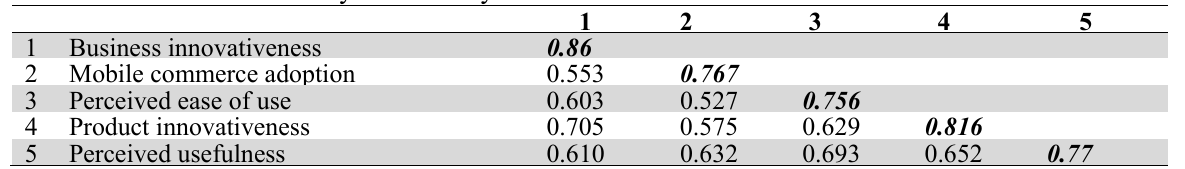
Results of construct reliability and